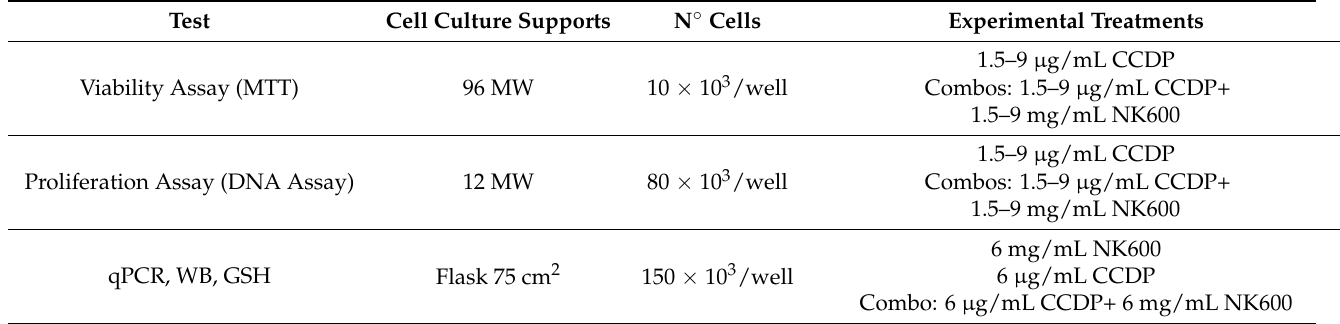
Table 1. Protocols in place based on tests